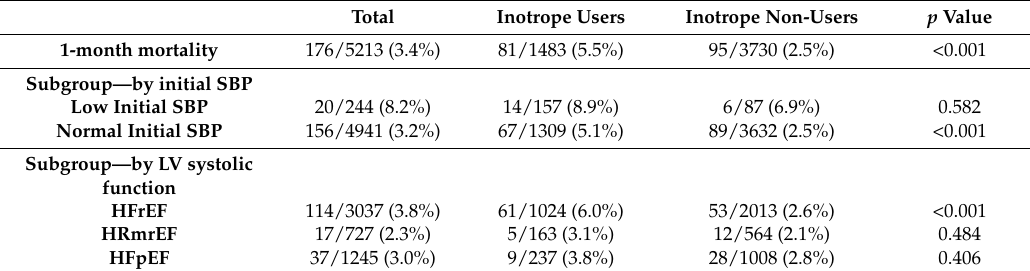
Table 4. Post-discharge 1-month clinical outcomes. SBP, systolic blood pressure; HFpEF, heart failure with preserved ejection fraction; HFrEF, heart failure with reduced ejection fraction.